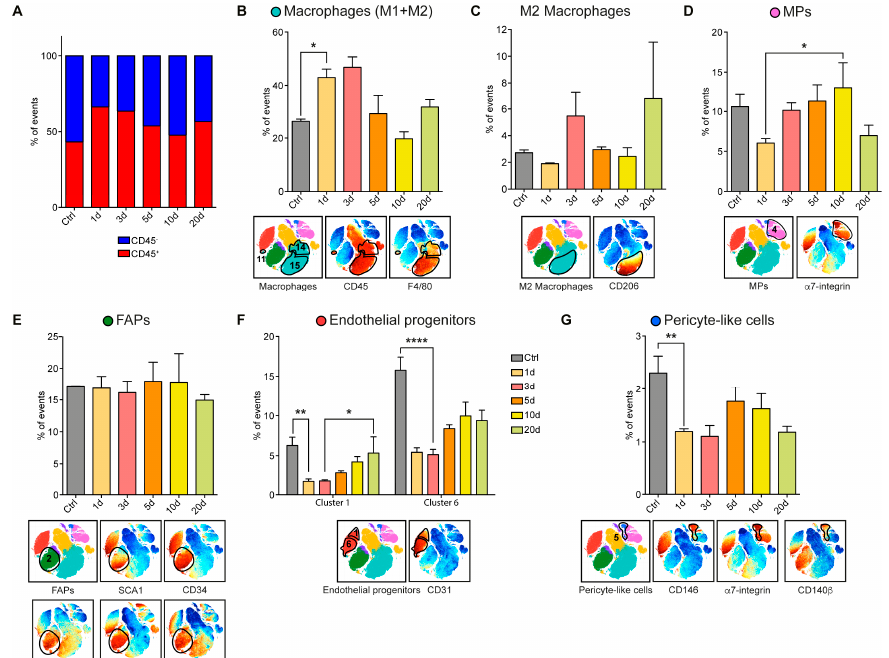
Figure 5. Characterization of the population dynamics induced by CTX injury in the mdx skeletal muscle at day 1, 3, 5, 10, 20 after injury. ( A ) Bar plots, showing the CD45 - (blue) / CD45 + (red) ratio in the mdx mononuclear cells at di ff erent time points after CTX injury. Data were represented as mean, and the statistical significance was estimated by two-way ANOVA. ( B ) t-SNE maps, showing the population gated as macrophage, colored for CD45 and F4 / 80 expression (red: high expression; blue: low expression) together with the macrophage trend observed in uninjured and CTX-injured mdx hind limb muscles. ( C ) M2 macrophages, expressing the CD206 antigen. ( D ) t-SNE maps of the myogenic progenitor (MP) population colored according to the levels of α 7-integrin expression (red: high expression) and MP population dynamics during regeneration. ( E ) t-SNE maps, representing fibro / adipogenic progenitors (FAPs) identified among uninjured and CTX-injured mdx hind limb muscles, colored according to the expression of SCA1, CD34, CD140 α , CD90.2, and vimentin (red: high expression; blue: low expression). The bar plot illustrated the population dynamics during regeneration. ( F ) Bar plots, showing the abundance of two di ff erent subclusters (cluster 1 and cluster 6) of endothelial progenitor cells at di ff erent time points. ( G ) t-SNE maps of pericyte-like cells identified in uninjured and CTX-injured mdx hind limb cell populations. Cell clusters were colored according to the expression of CD146, α 7-integrin, and CD140 β (red: high expression; blue: low expression). The bar plot illustrated the population dynamics during regeneration. Population abundance was assessed by calculating the percentage of cells in any given population over the total number of mononuclear cells in each sample (n = 3). The statistical significance was estimated by one-way ANOVA. All data were represented as mean ± SEM, and the statistical significance was defined as * p < 0.05; ** p < 0.01; **** p <